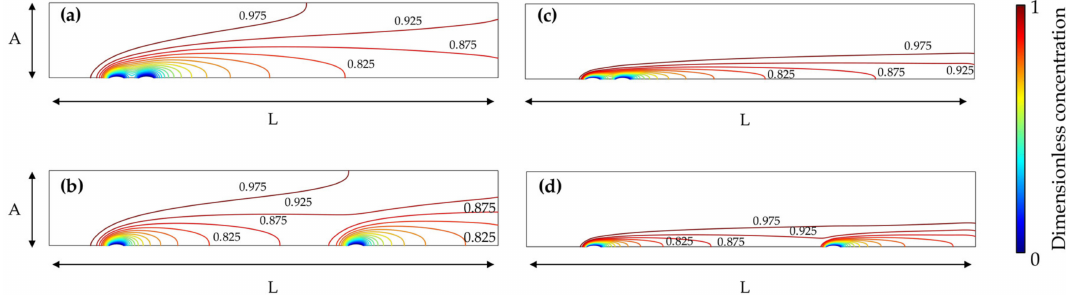
Figure 8. Contour plots of the dimensionless concentration for the bumped electrodic geometry with dimensionless channel height A = 5 du, dimensionless channel length L = 30 and variable electrode-electrode interdistance f for: ( a ) Pe = 10, f = 1; ( b ) Pe = 10, f = 15; ( c ) Pe = 100, f = 1; ( d ) Pe = 100, f = 15. Mesh size d = 0.02